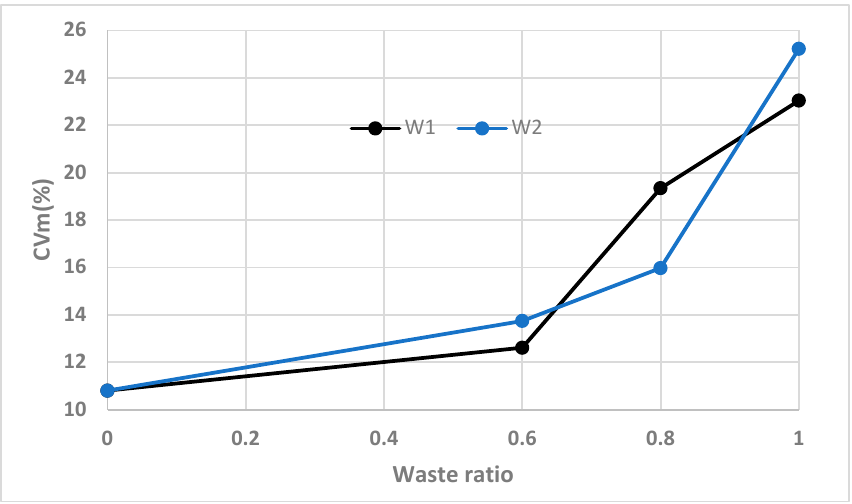
Figure 3. The effect of the proportion of waste fibre content on the irregularity of blended yarns.